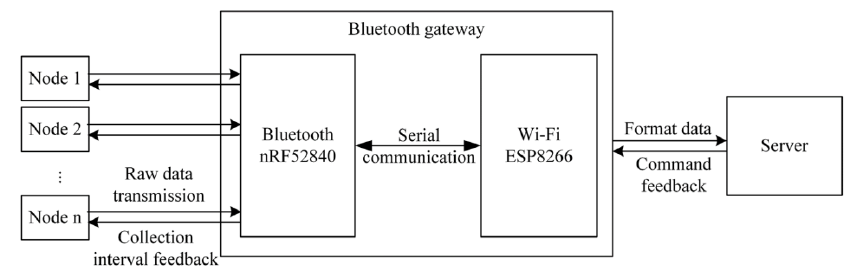
Figure 3. The Bluetooth gateway information transmission system function design.